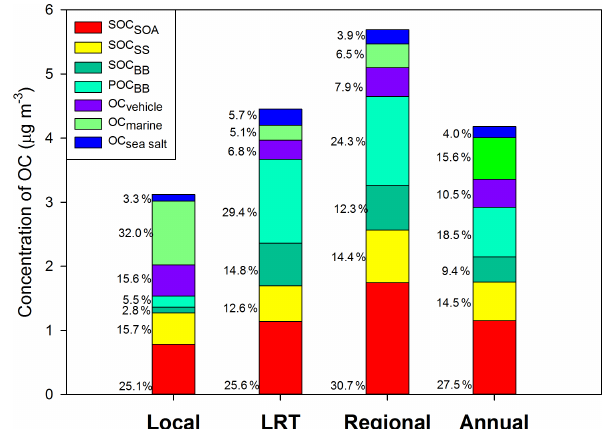
Figure 3. Source-specific contributions to OC under different me- teorological conditions. OC BB was split into POC BB and SOC BB